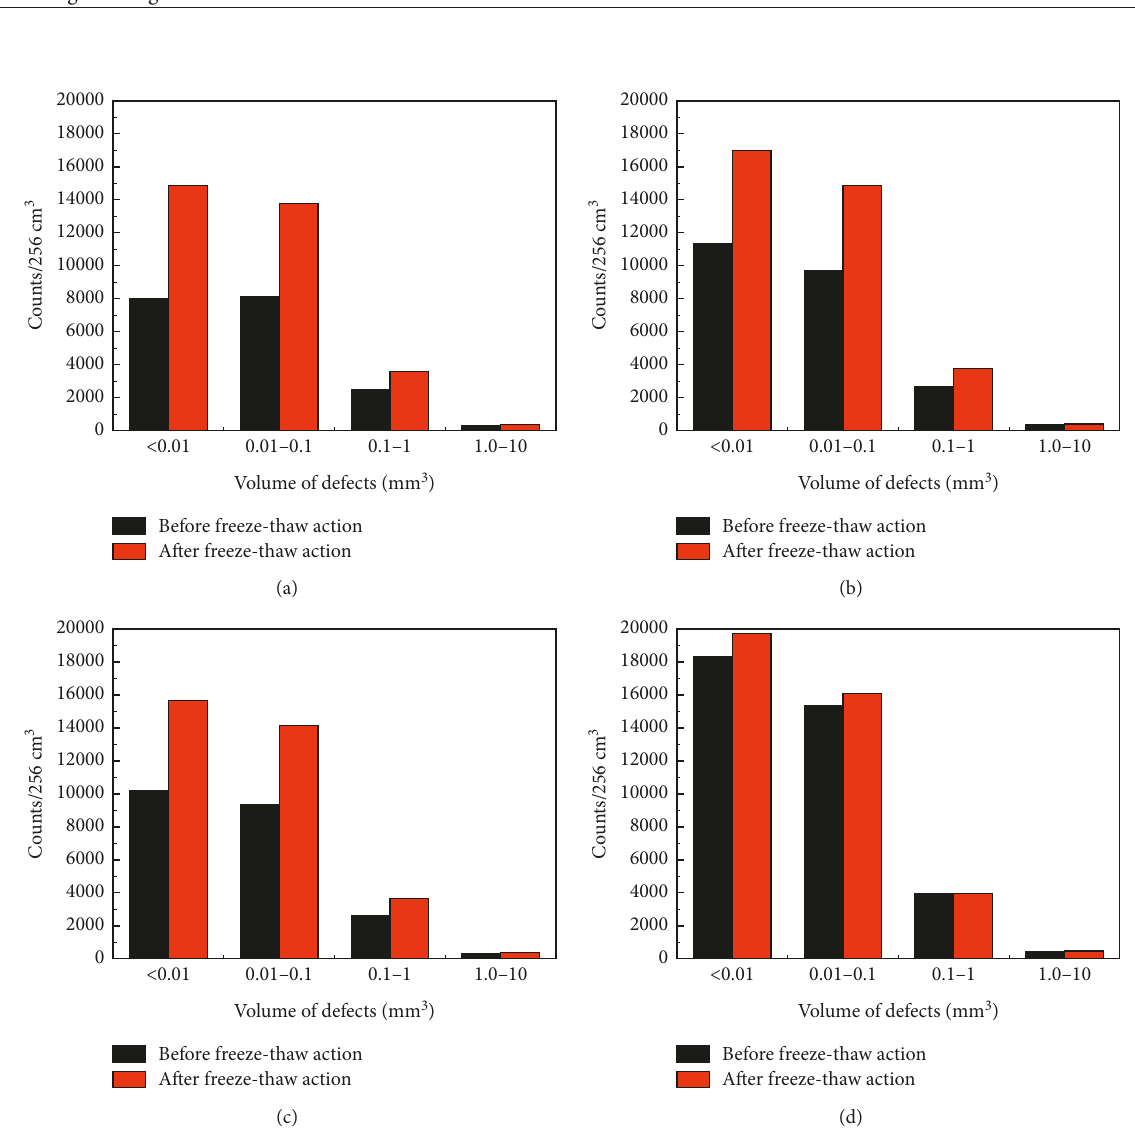
Figure 11: Defects volume distributions of UHPC specimens before and after freezing-thawing tests: (a) plain UHPC, (b) UHPC-1%, (c) UHPC-2%, and (d) UHPC-3%.